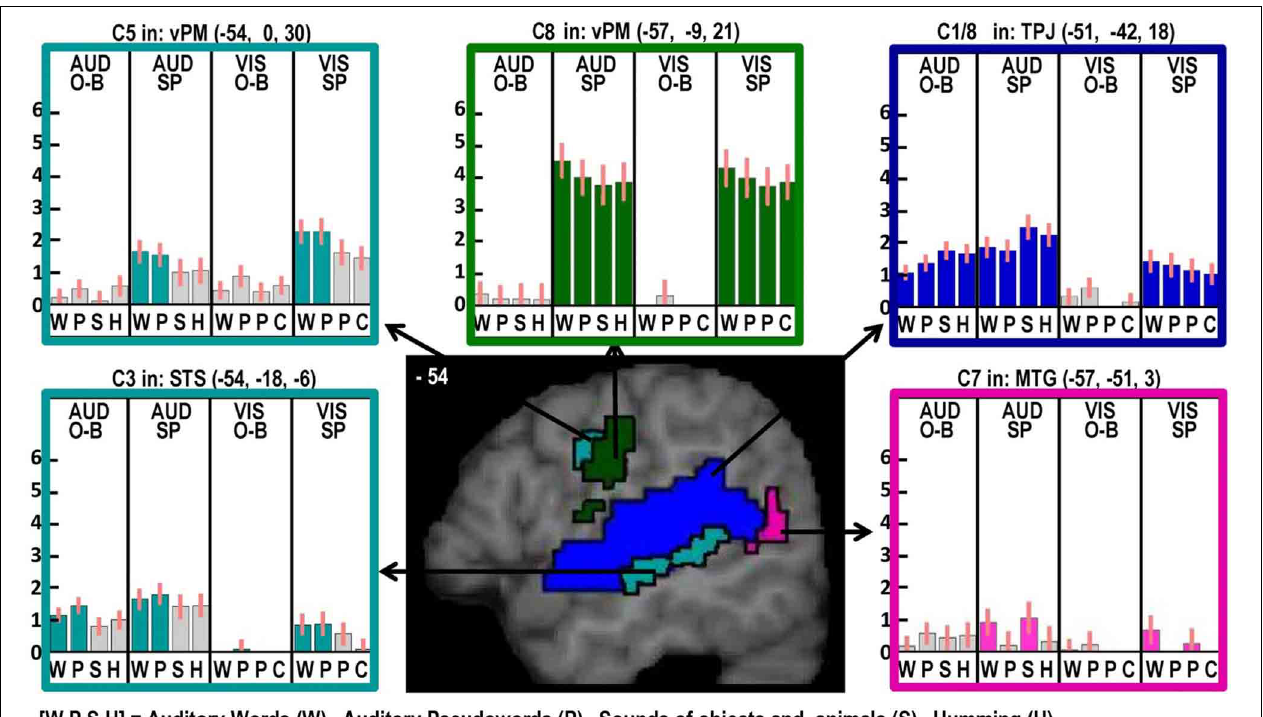
FIGURE 2 | Illustrations of activations related to auditory processing (in blue), phonological processing (in turquoise), semantic processing (in pink) and the motor execution of speech (in dark green) on a single sagittal brain image at x = − 54 in MNI space. Plots show the response for each of the 16 conditions in each of the regions of interest, with the name of the brain region, the x, y, and z MNI co-ordinates of the effect and the